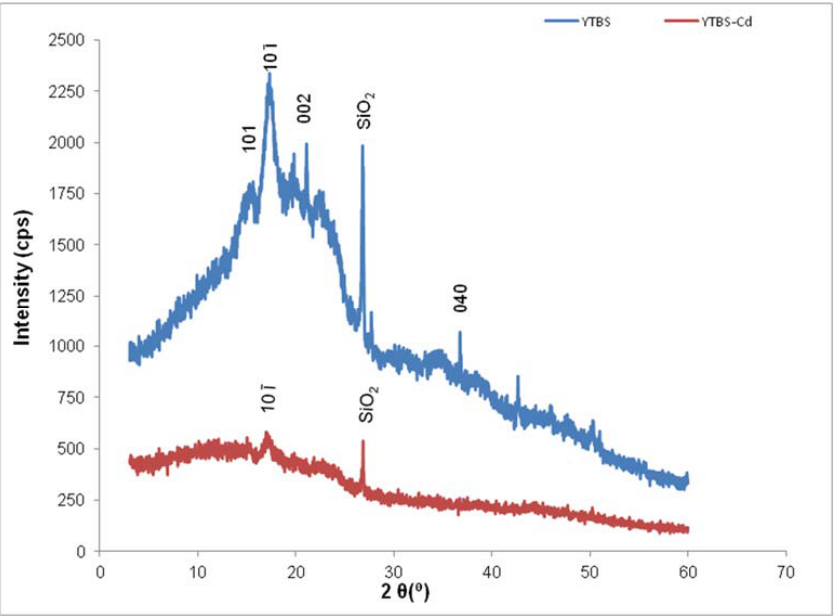
Figure 7. XRD of YTBS residue adsorbent before and after Cd(II) sorption.